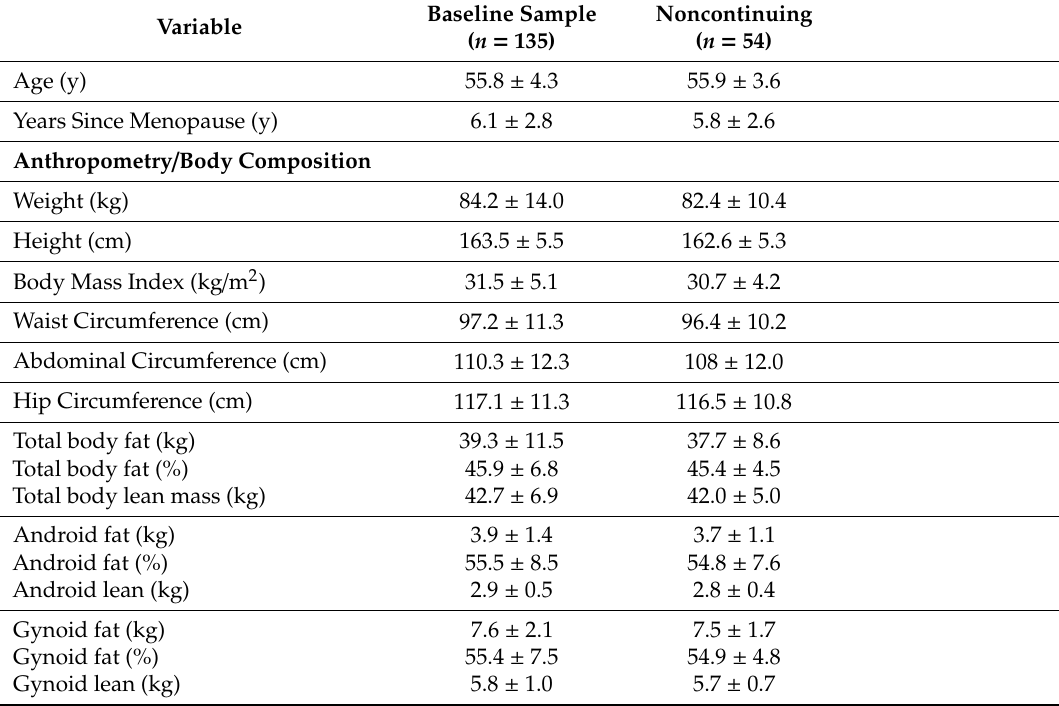
Table 1. Anthropometrics, bone and body composition characteristics, and relevant lab values (mean